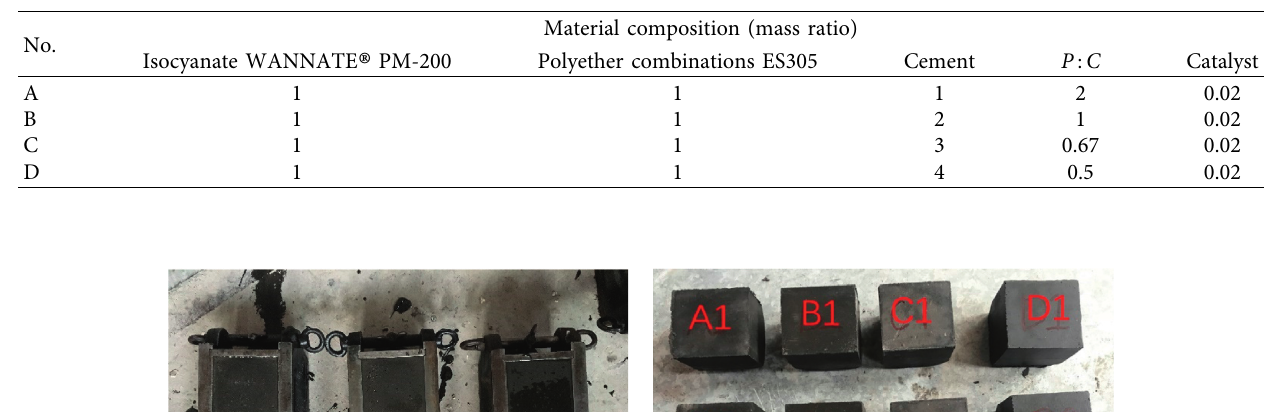
Table 4: Mix proportion of PUC.